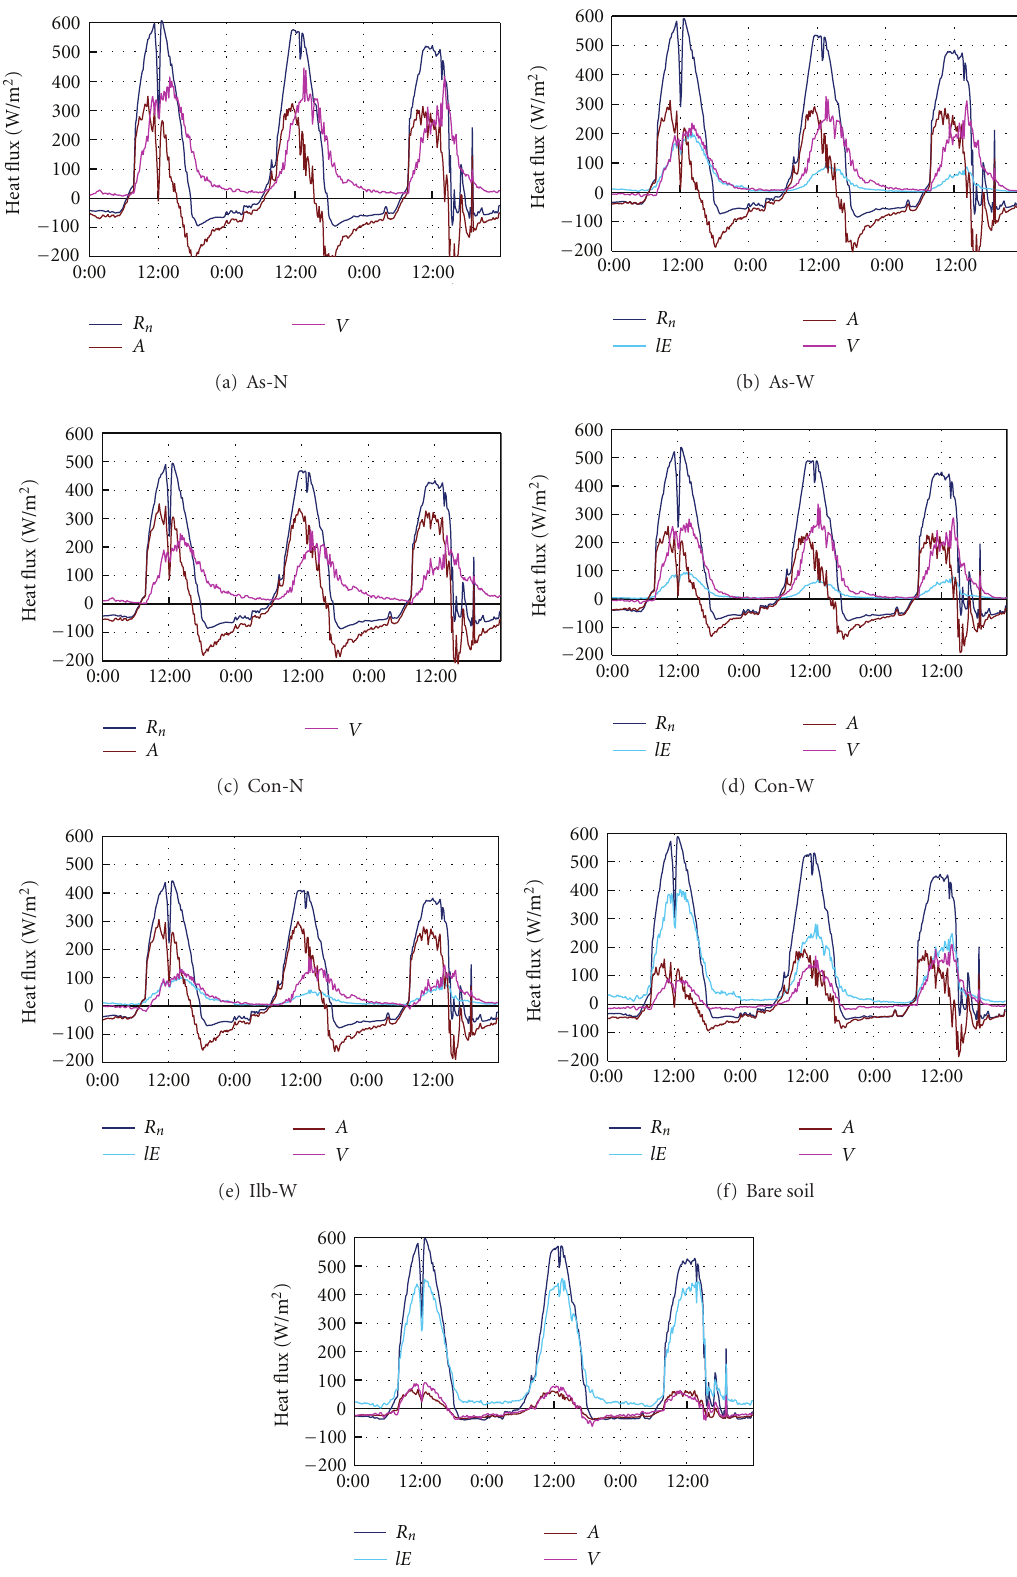
Figure 12: Values of surface heat budget estimated for each pavement surface on August 3 to 5,